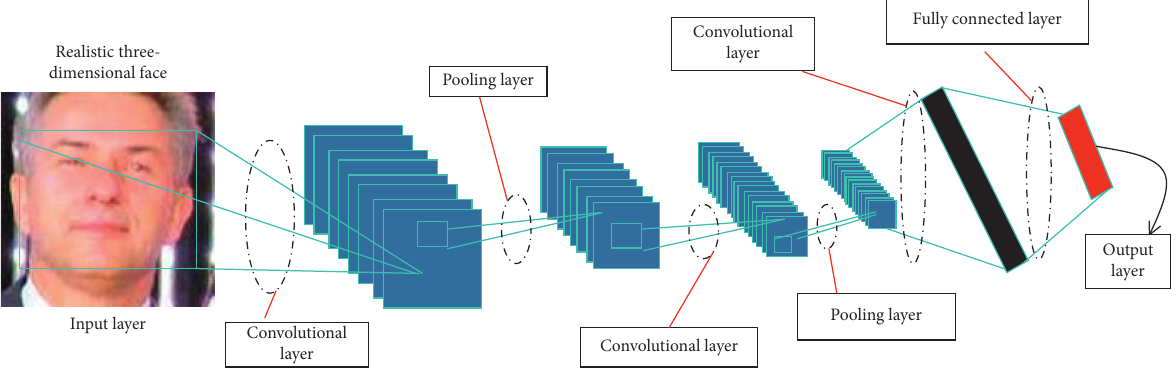
Figure 2: Depth separable convolution